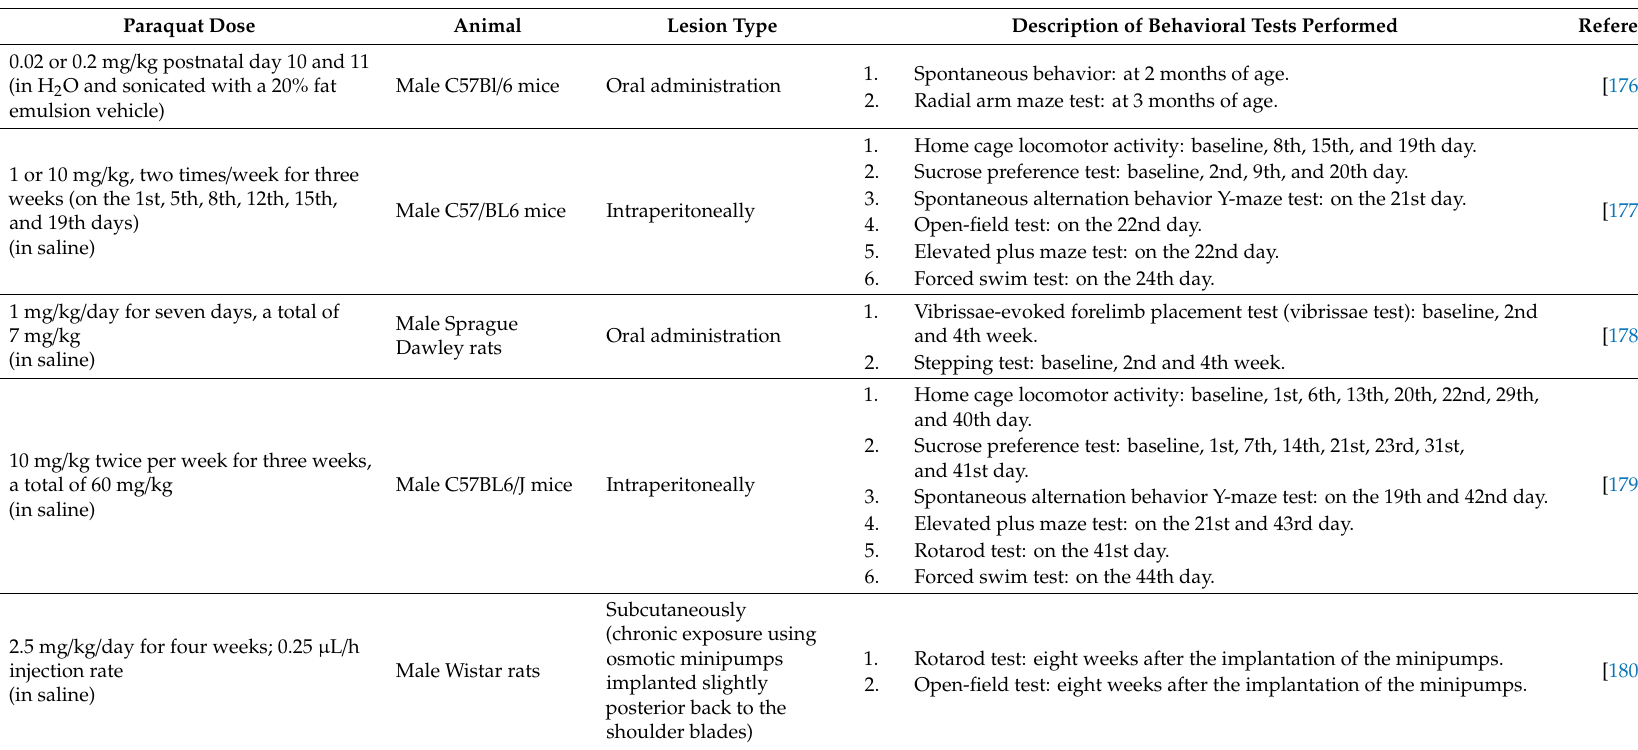
Table 5. The dose, lesion type, and behavioral evaluating methods in each paraquat-induced PD animal